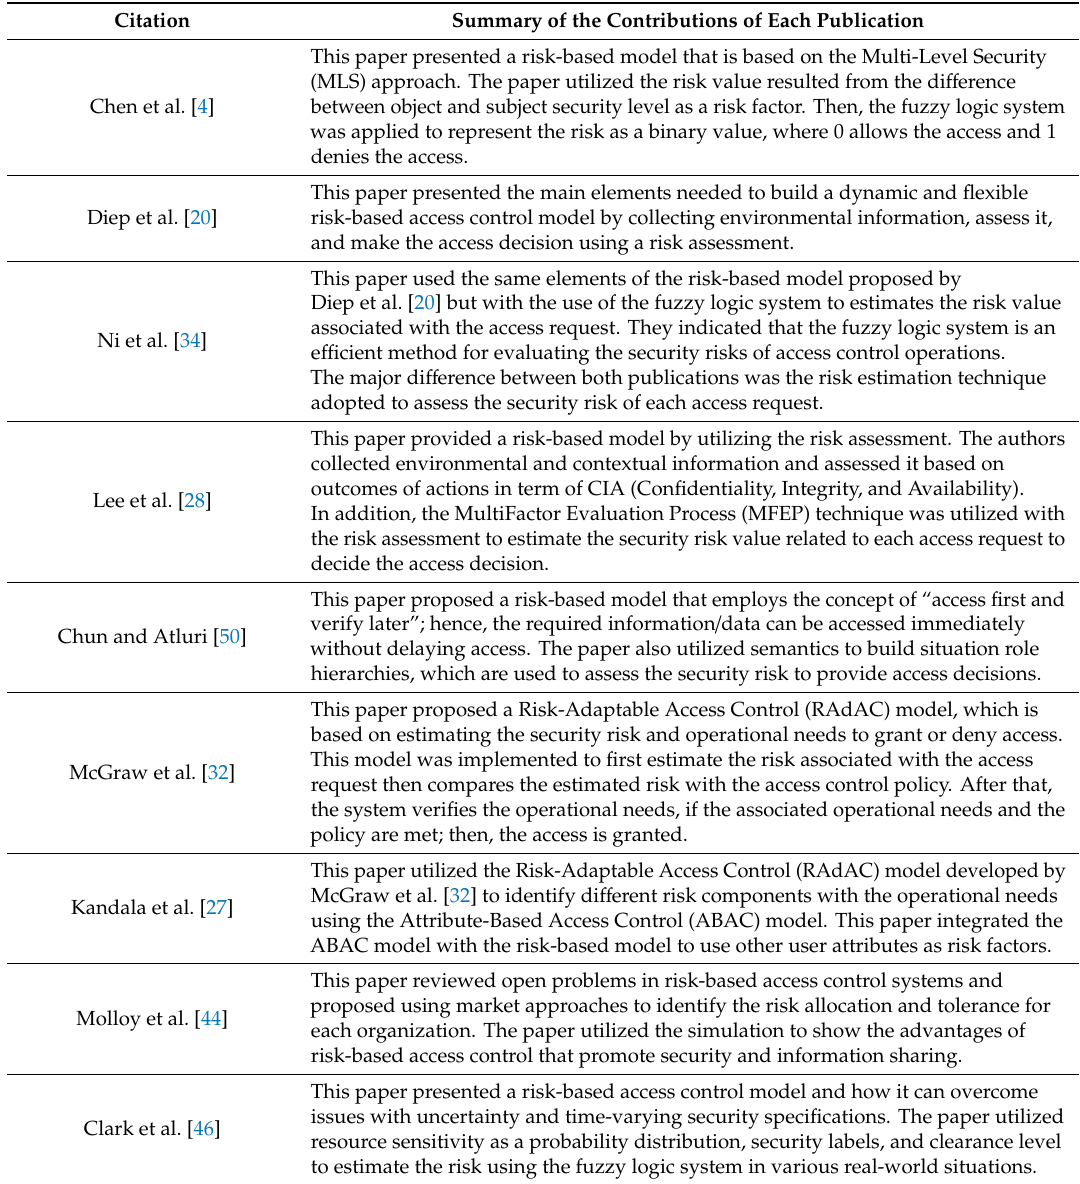
Table 4. Summary of recent studies outlined risk-based access control